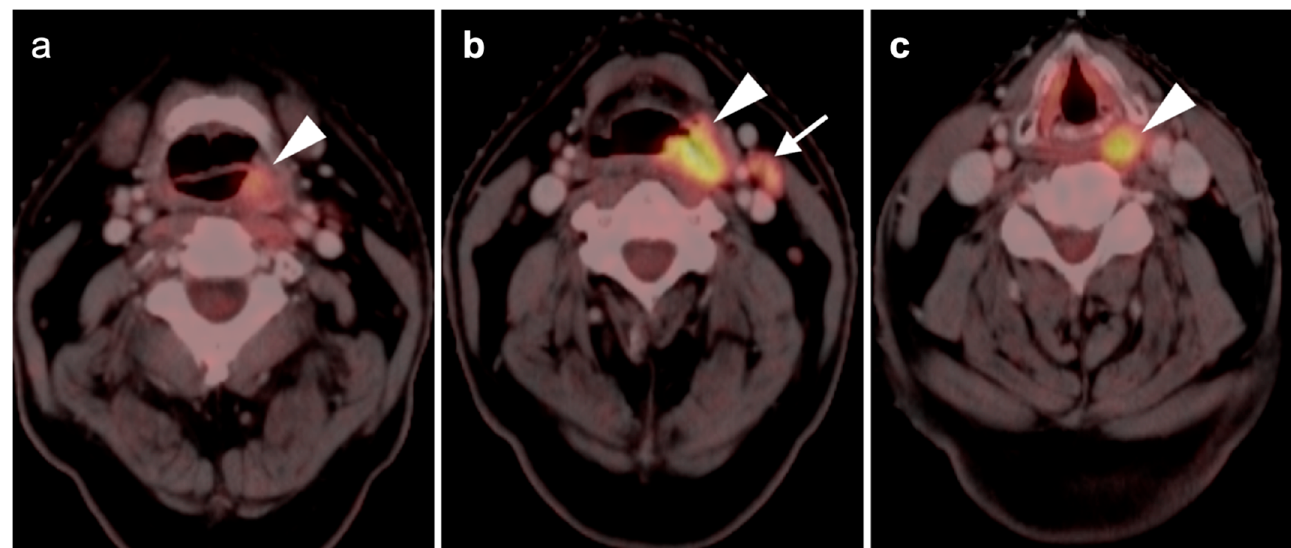
Figure 15. Hypopharyngeal squamous cell carcinoma. ( a ) Hypermetabolic tumor extends superiorly to the left superior aryepiglottic fold (white arrowhead). ( b ) The lesion is centered around the left pyriform sinus (white arrowhead) with involvement of a left level 2A hypermetabolic lymph node (white arrow). ( c ) Inferiorly, the tumor extends to the junction of the hypopharynx and cervical esophagus (white arrowhead) along the lateral wall of the hypopharynx at the level of the cricoid.